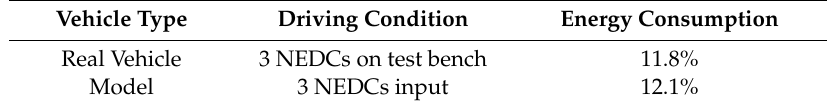
Figure 2. Two driving cycles to verify the accuracy of the EV model: ( a ) the 3 new energy driving cycles (NEDCs) on the test bench; ( b ) the actual road driving cycle. Table 1. Comparison of energy consumption between the real vehicle and the model for 3 NEDCs.